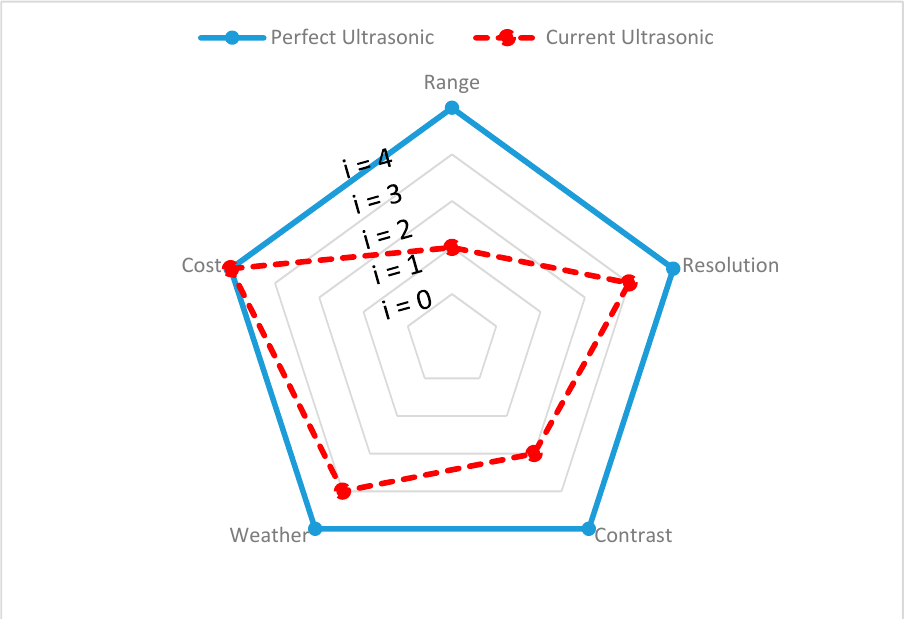
Figure 7. Ultrasonic sensor spider chart, showing performance gap.